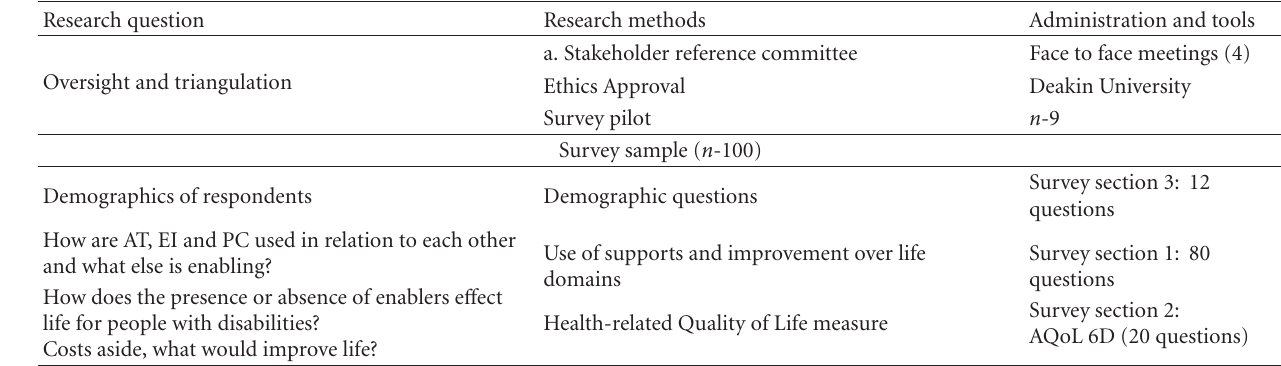
Table 1: Description of Research